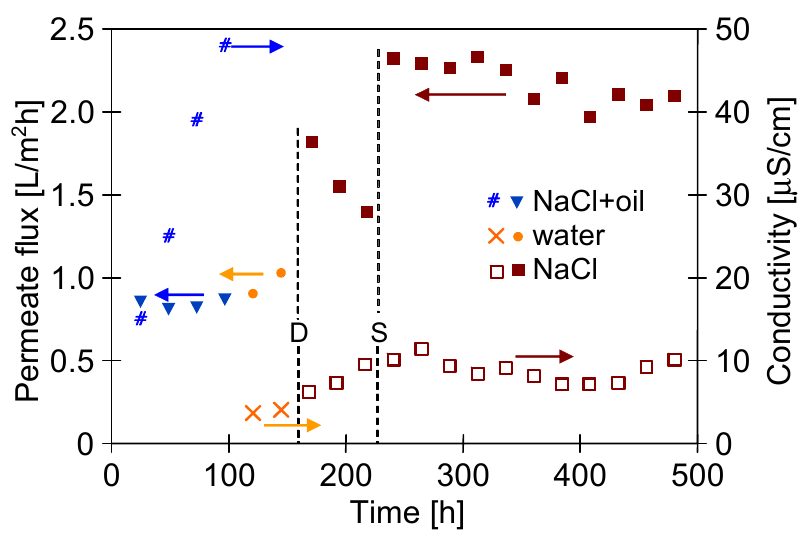
Figure 15. Changes in the permeate flux and distillate conductivity during the MD process of NaCl solution (300 g/L) contaminated by oil (70–120 mg/L). T F = 60 °C, module M#3. Points: D—membrane drying; S—membranes rinsed by S316.